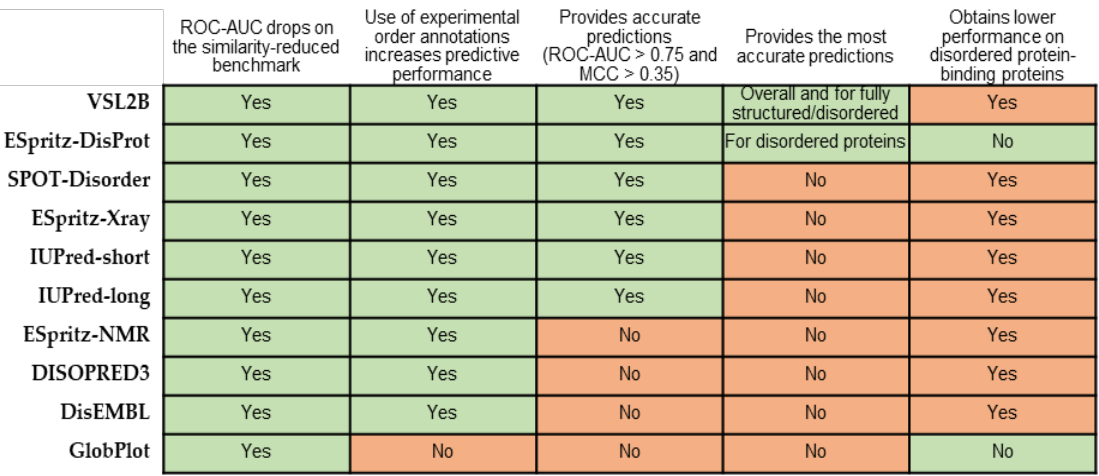
Figure 4. Summary of the empirical comparative results.